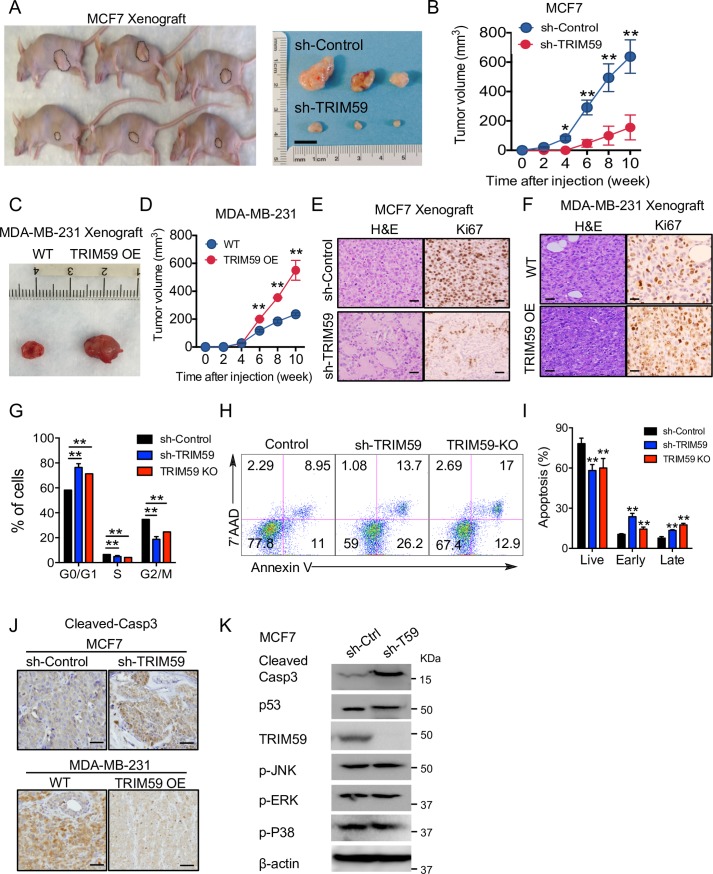
TRIM59 promotes the tumor growth and survival of breast cancer cells in vivo.(A and B) Representative tumor images (A) and tumor volume at indicated time points (B) in nude mice that were orthotopically injected into mammary fat-pad with control (non-targeting shRNA) or shTRIM59 MCF7 cells (1 × 107 cells/mouse). n = 9 mice per group. (C and D) Representative tumor images (C) and tumor size quantification at indicated time points (D) in NSG mice that were orthotopically injected into mammary fat-pad with control and TRIM59 OE MDA-MB-231 cells (5 × 106 cells/mouse). n = 5 mice per group. (E and F) Representative image of shControl or shTRIM59 MCF7 xenografts (E) and control or TRIM59 OE MDA-MB-231 (F) xenograft tumors stained with HE and Ki-67. Scale bars: 20 μm. (G) Cell cycle analysis on Control, shTRIM59, and TRIM59 KO MCF7 cells by flow cytometry. The population of cells at each stage was shown in the bar graph. n = 6. **P < 0.01 versus control. (H and I) Apoptotic assessment of shControl, shTRIM59, and TRIM59 KO MCF7 cells. Apoptosis was assayed with Annexin V/7-AAD staining and measured by flow cytometry (H). Statistical analysis of cell populations at early or late stages of apoptosis (I). Live, 7’AAD−AnnexinV−; Early, 7’AAD−AnnexinV+; Late, 7’AAD+AnnexinV+. n = 6. (J) Representative images of cleaved-caspase3 expression in paraffin sections from xenograft tumors made of shControl or shTRIM59 MCF7 cells (top) and WT or TRIM59 OE MDA-MB-231 cells (bottom). n = 6. Scale bars: 10 μm. (K) IB analysis of cell cycle/apoptosis regulators (p53 and MAP kinase pathway members) expression in shControl or shTRIM59 MCF7 cells. Data in B, D, G, and I are presented as means ± SD. *P < 0.05, **P < 0.01 versus controls. The underlying data can be found in S1 Data. Casp3, caspase3; HE, hematoxylin–eosin; Ki-67, marker of proliferation; KO, knockout; MAP, mitogen-activated protein; NSG, NOD scid gamma; OE, overexpressed; p-ERK, phosphorylation of extracellular signal–regulated kinase (ERK); p-JNK, phosphorylation of c-Jun N-terminal kinase (JNK); p-P38, phosphorylation of P38 MAP kinase; p53, tumor protein 53; shRNA, short hairpin RNA; TRIM59, tripartite motif 59; WT, wild-type.